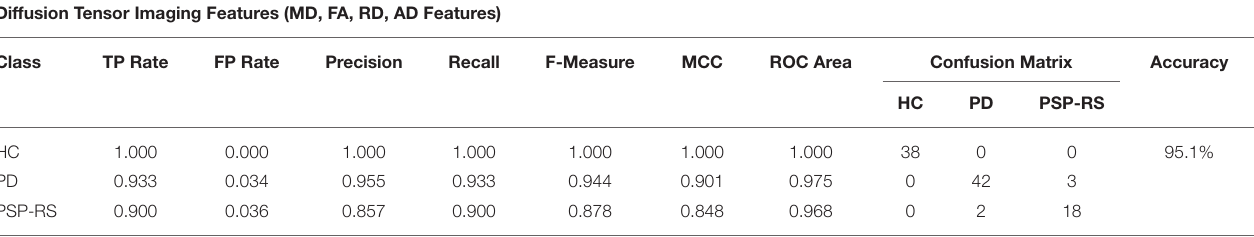
TABLE 5 | Confusion matrix following an information gain + LMT classification combination using DTI maps only. Diffusion Tensor Imaging Features (MD, FA, RD, AD